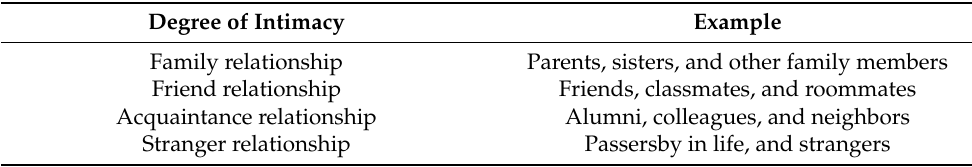
Table 1. Classification of intimacy